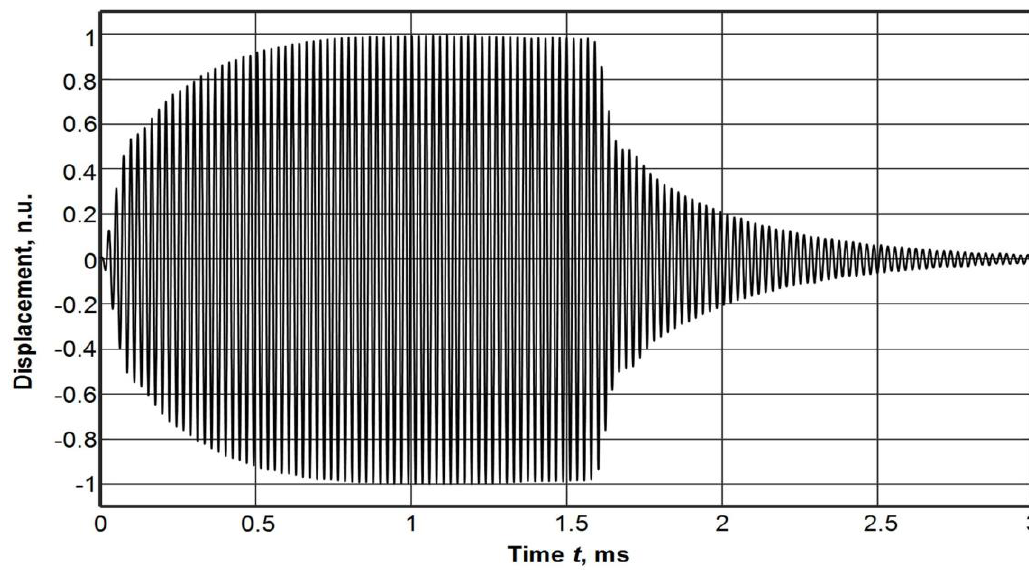
Figure 10. The normal displacement signal of the PVC film measured above the centre of the transducer radiating surface.